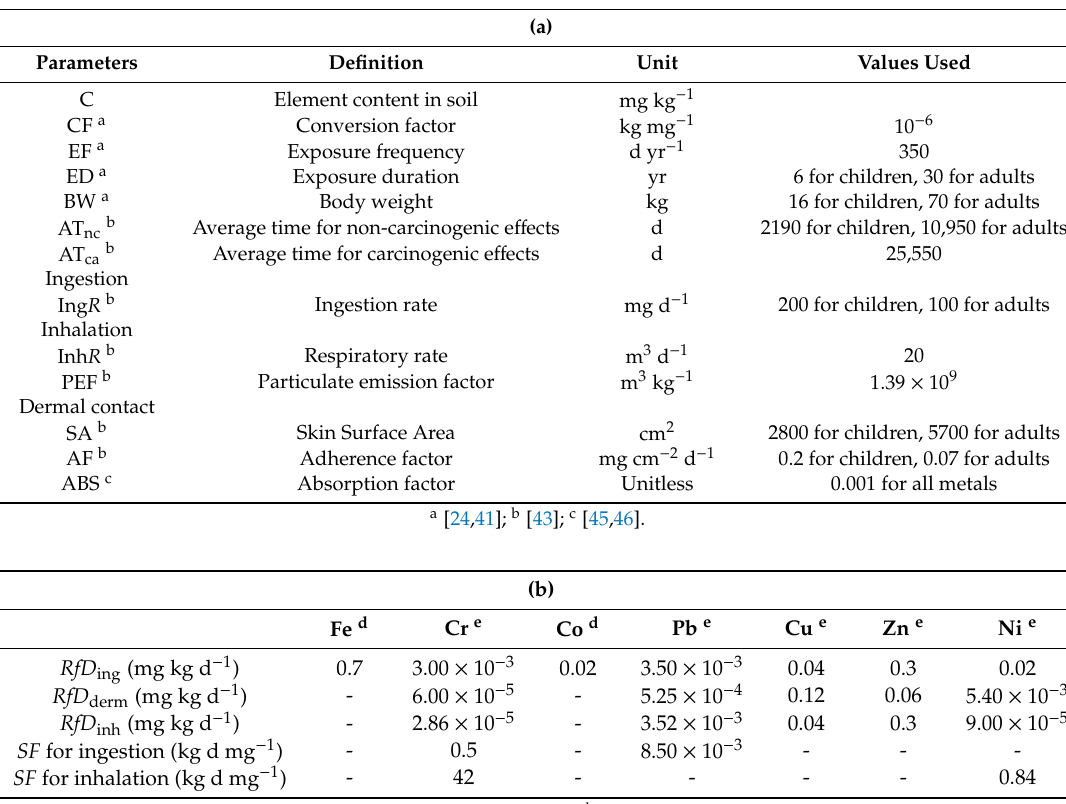
Table 1. ( a ) Summary of health risk parameters used in Equations (2)–(4). ( b ) Summary of health risk parameters used in Equations (5) and